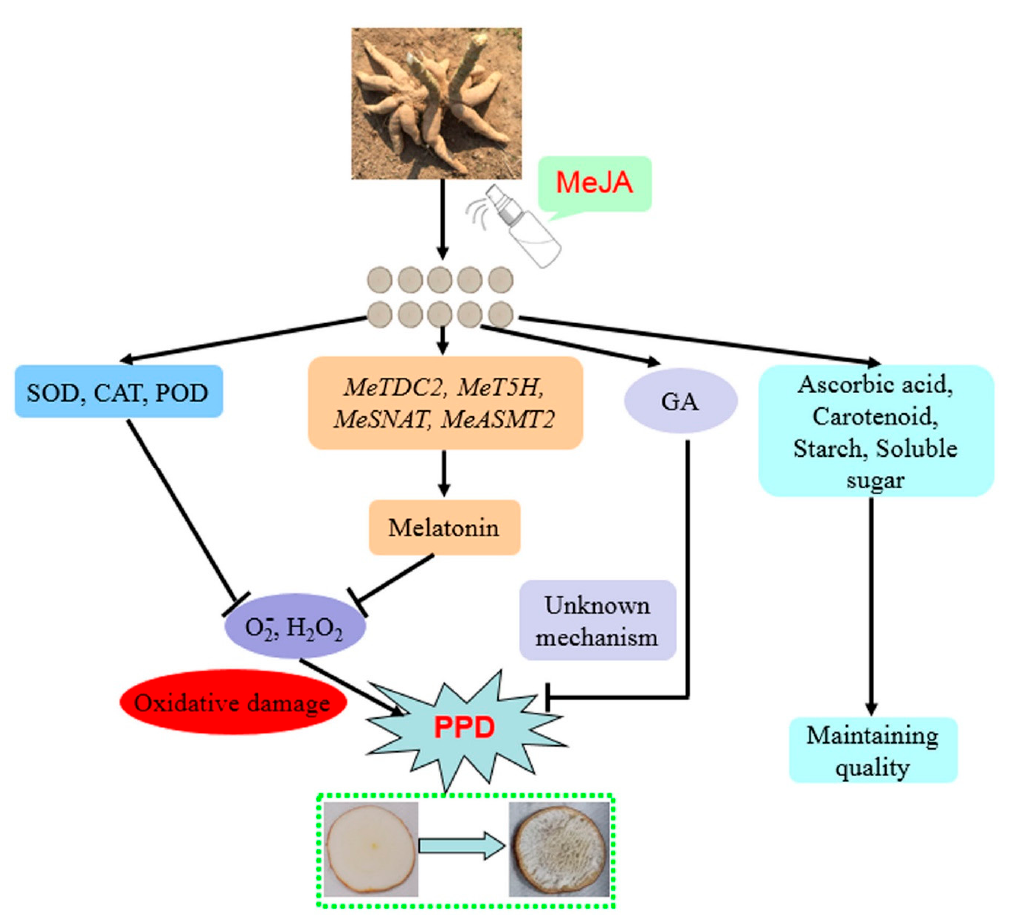
Figure 7. A possible model of MeJA-mediated cassava PPD.